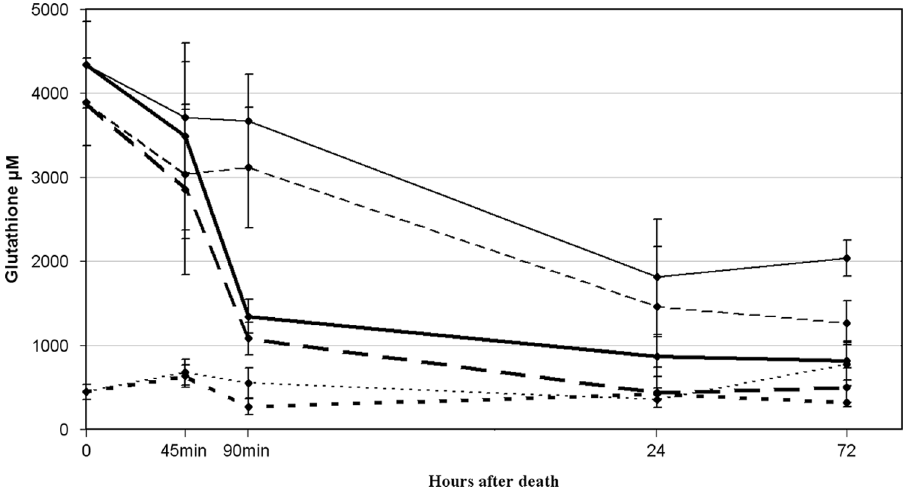
Figure 1. Glutathione of invitro stored lenses. In vitro Optisol-GS stored lenses showed a rapid drop in concentration at 1 K hour, which was not observed with castor oil. A significant effect of the storage media is observed after 72 hours, with castor oil stored lenses retaining three times the amount of Optisol-GS stored lenses. Total glutathione is shown as full lines, GSH as large dotted and GSSG as small dotted lines. Bold lines show the progression in Optisol-GS and thin lines in castor oil.